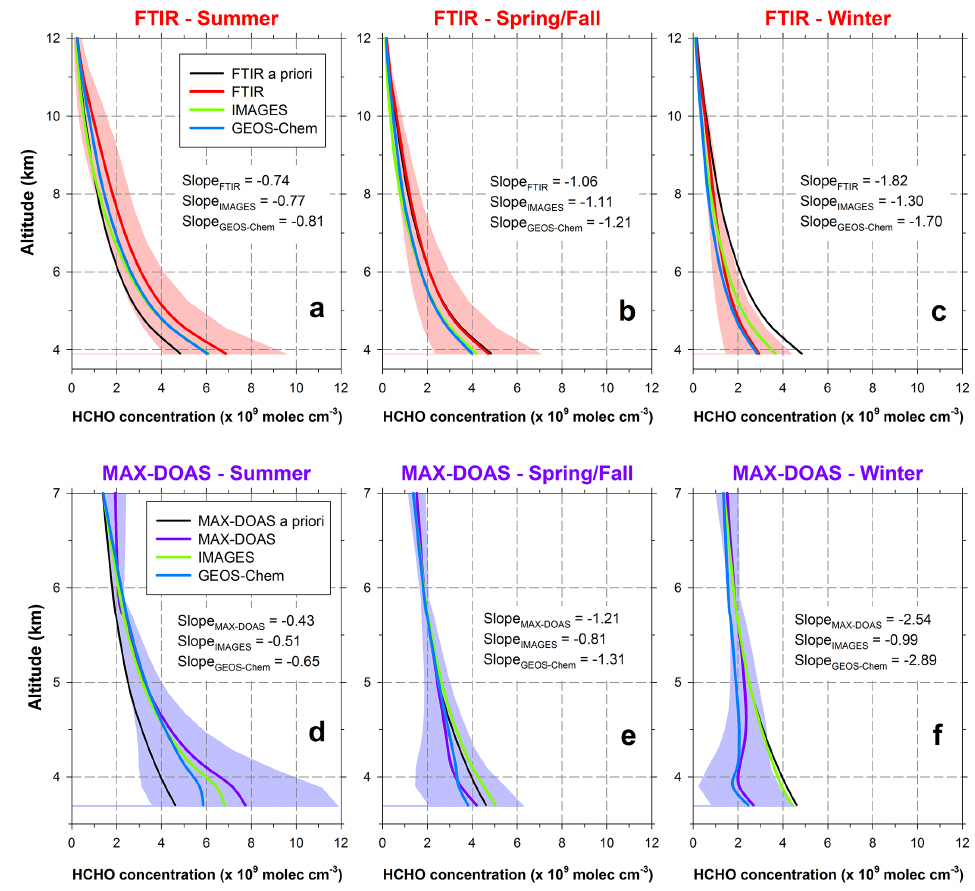
Figure 5. Mean seasonal profiles of HCHO concentration (in moleccm − 3 ) above Jungfraujoch according to the FTIR and MAX-DOAS retrievals (upper and lower frames, respectively), calculated on the basis of the daily means over the July 2010–December 2012 time period. The shaded areas correspond to the 1 σ SD around the mean profiles. The smoothed profiles derived from the IMAGES (in green) and GEOS- Chem (in blue) simulations have been added to each frame. The mean slope of each profile has been estimated by adjusting a linear regression between 3.6 and 7km altitude with the least mean squares